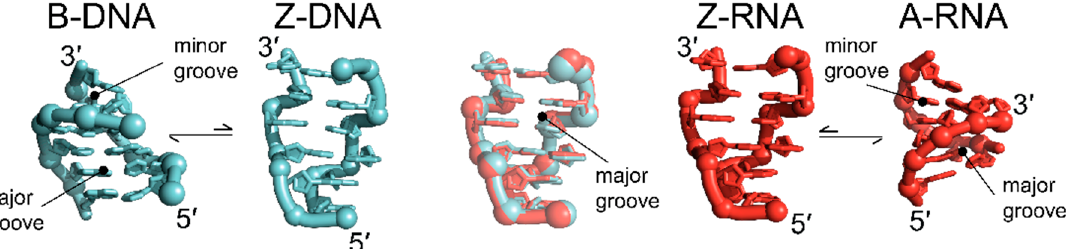
Figure 1. Z-DNA and Z-RNA are structurally equivalent. Although the right-handed B- (left, cyan, PDB: 1N1K [24]) and A-conformations (right, red, PDB: 1PBM [25]) of helical DNA and RNA are structurally distinct from each other, they can both adopt the left-handed Z-conformation (middle, PDBs: 1QBJ [7] for DNA and 2GXB [10] for RNA). Unlike the phosphate backbones of A- and B-conformation nucleic acids, which follow a smooth curve, the backbone of the Z-conformation zig-zags. Overall, the helical parameters of Z-DNA and Z-RNA are very similar (Table 1), with the opening of the minor groove of Z-RNA only being marginally smaller than that of Z-DNA. Table 1. Helical parameters for nucleic acids in their left- and right-handed conformations. Helix Sense